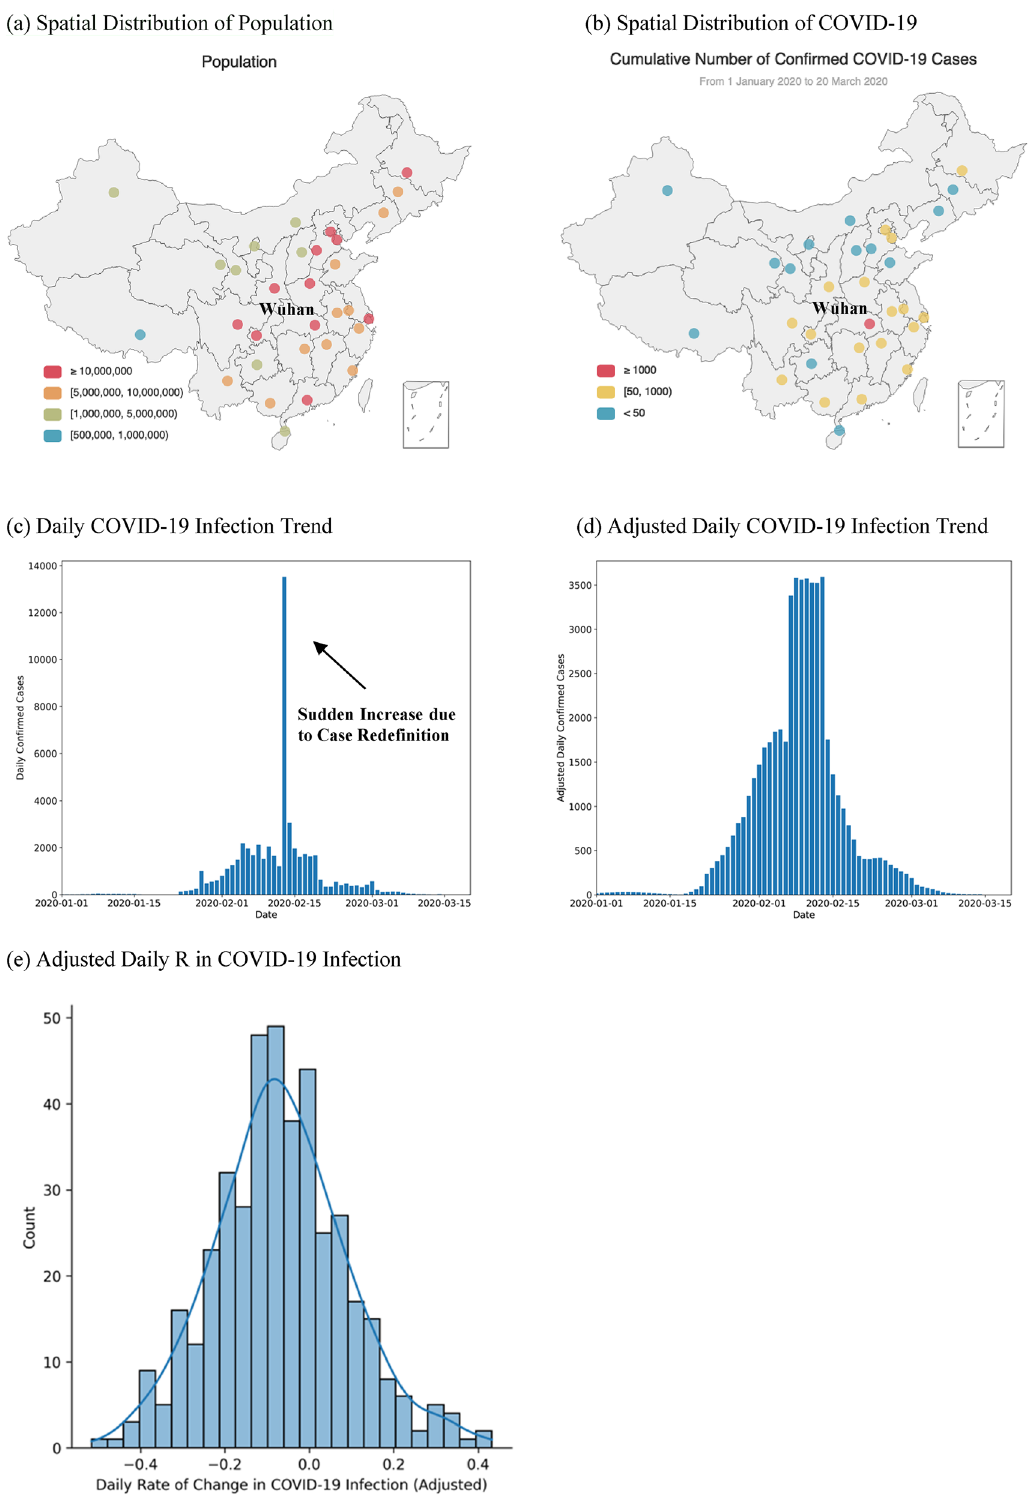
Figure 1. (a) Distribution of population across all provincial capital cities, (b) distribution of the cumulative number of confirmed COVID-19 cases across all provincial capital cities, (c) daily number of COVID-19 infection across all provincial capital cities, (d) adjusted daily number of COVID-19 infection across 18 high infection provincial capital cities, and (e) adjusted daily R in COVID-19 infection across 18 high infection provincial capital cities, China, from 1 January 2020 to 20 March 2020. The two maps in (a,b) were created by an open source Python library, pyecharts (version number: 1.9.0, URL: https:// pyech arts.